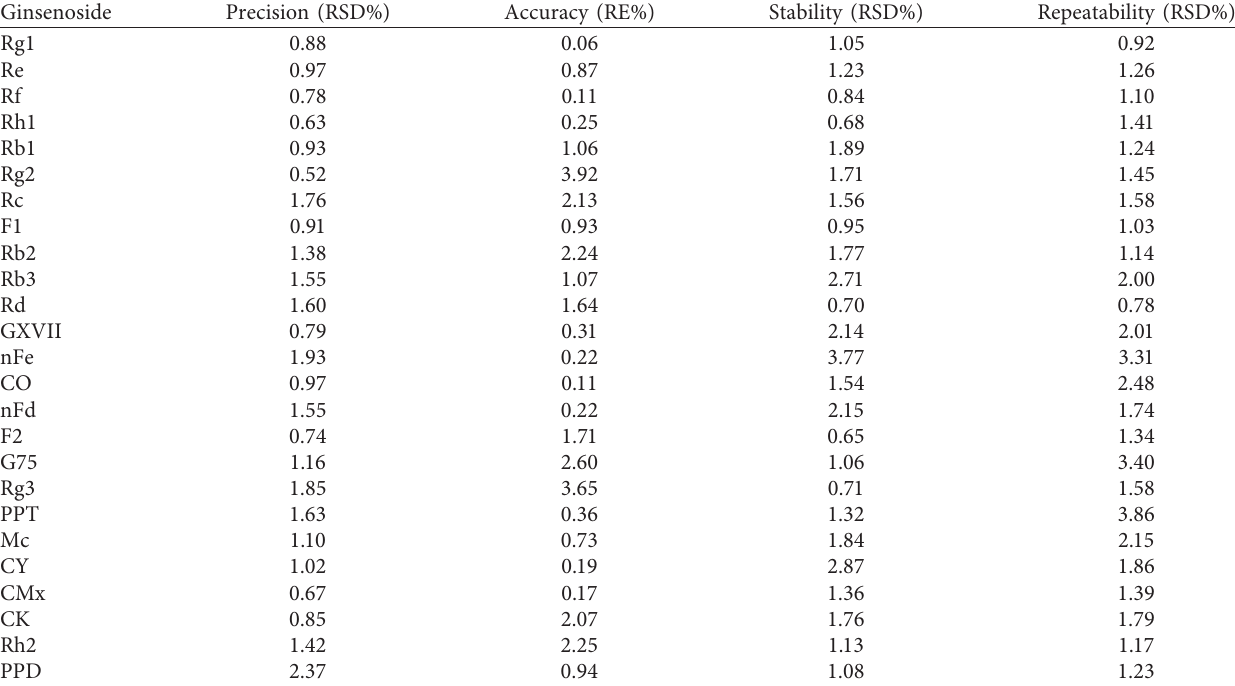
Table 2: Instrument precision, accuracy, sample stability, and repeatability of the assay ( n � 6).